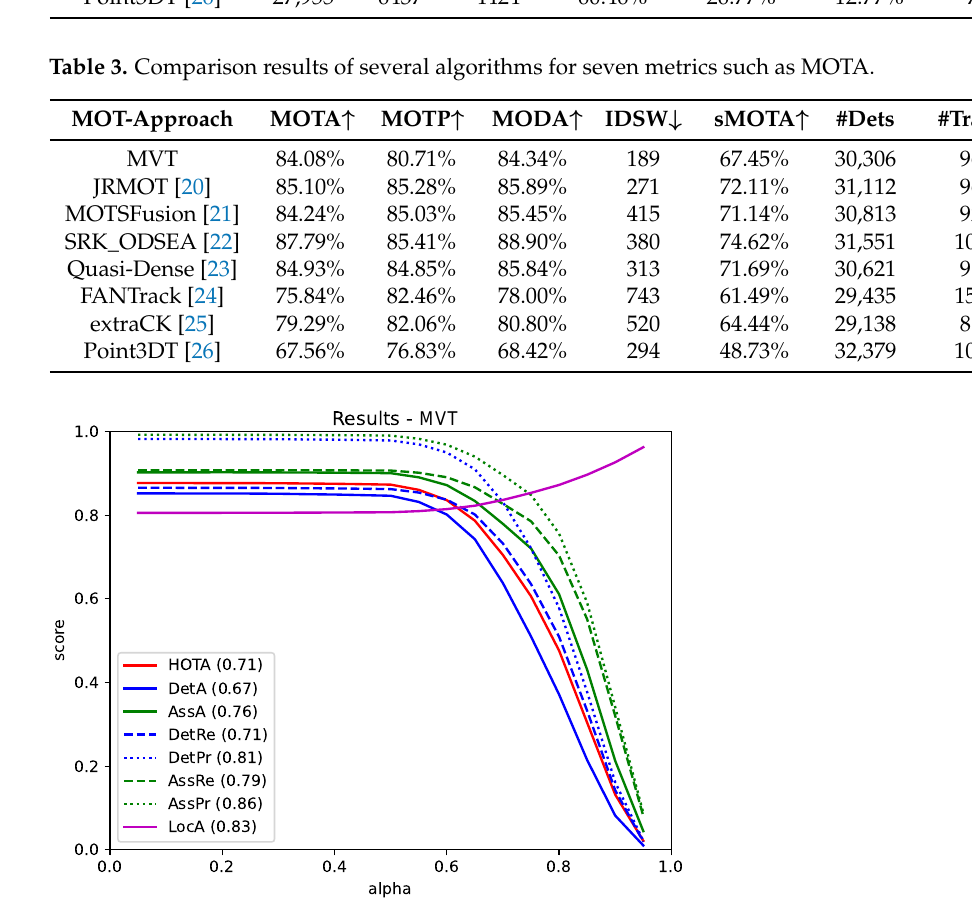
Figure 3. The detailed information of the evaluation metrics, HOTA, DetA, AssA, DetRe, DetPr, AssRe, AssPr, and LocA. The alpha is a threshold to compute the